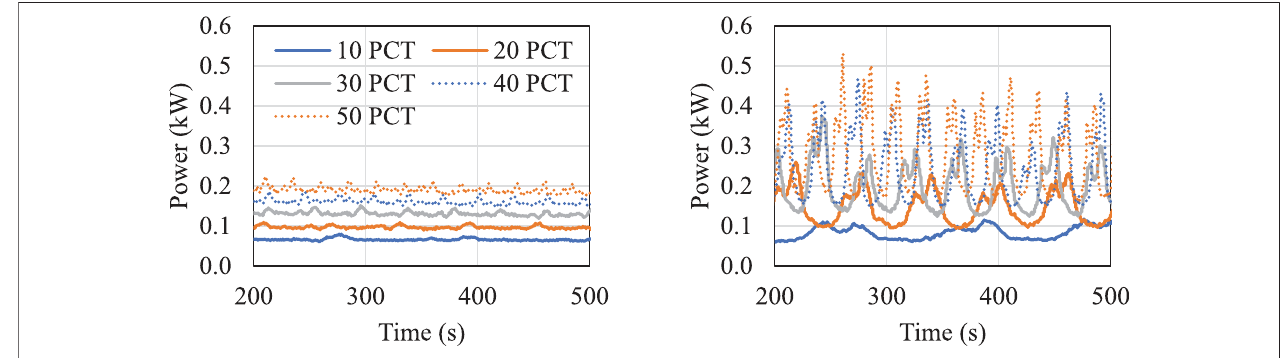
FIGURE 13 | Power consumption in the Acrison ® screw feeder at a controlled speed for (left) S7 and (right) S8. The solid blue, orange, gray, dotted blue, and orange indicate results at auger rotational speeds of 10, 20, 30, 40, and 50%, respectively.